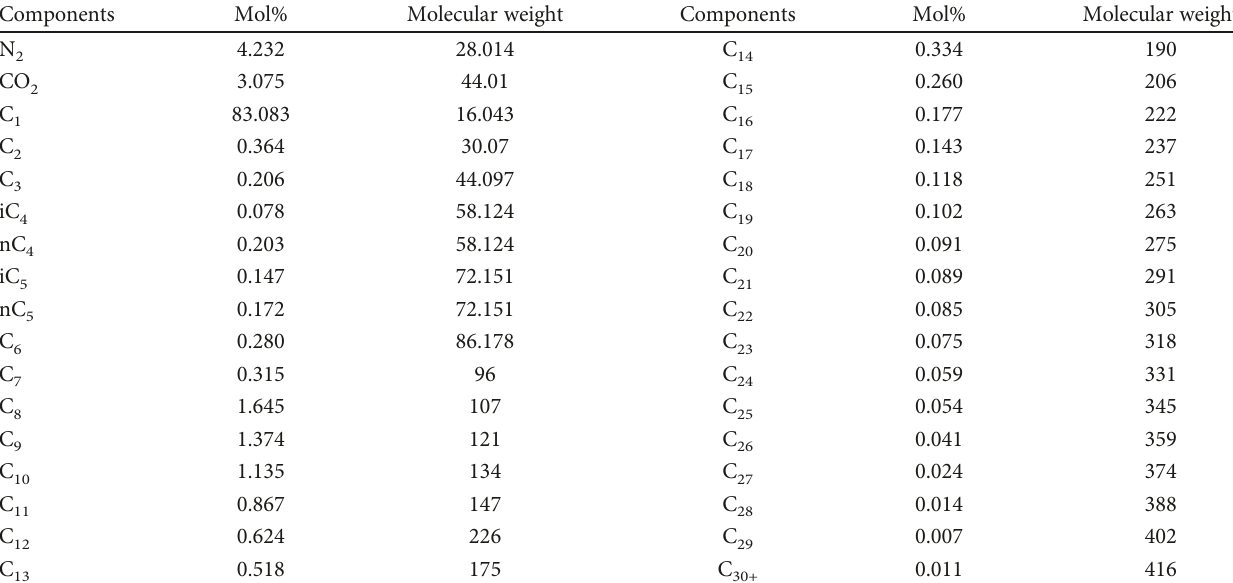
-C ) of the Lianglitage (O 1 30+